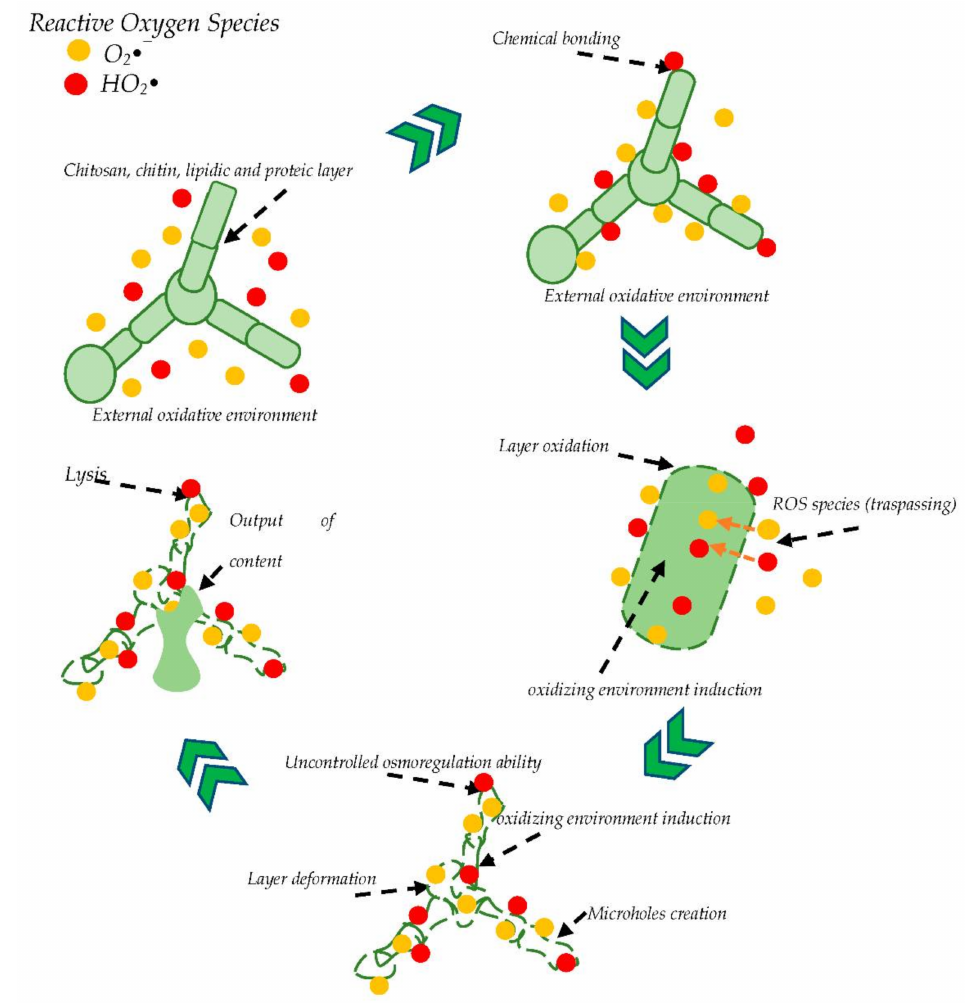
Figure 5. Disinfection mechanism purposed for Fungi using TiO 2